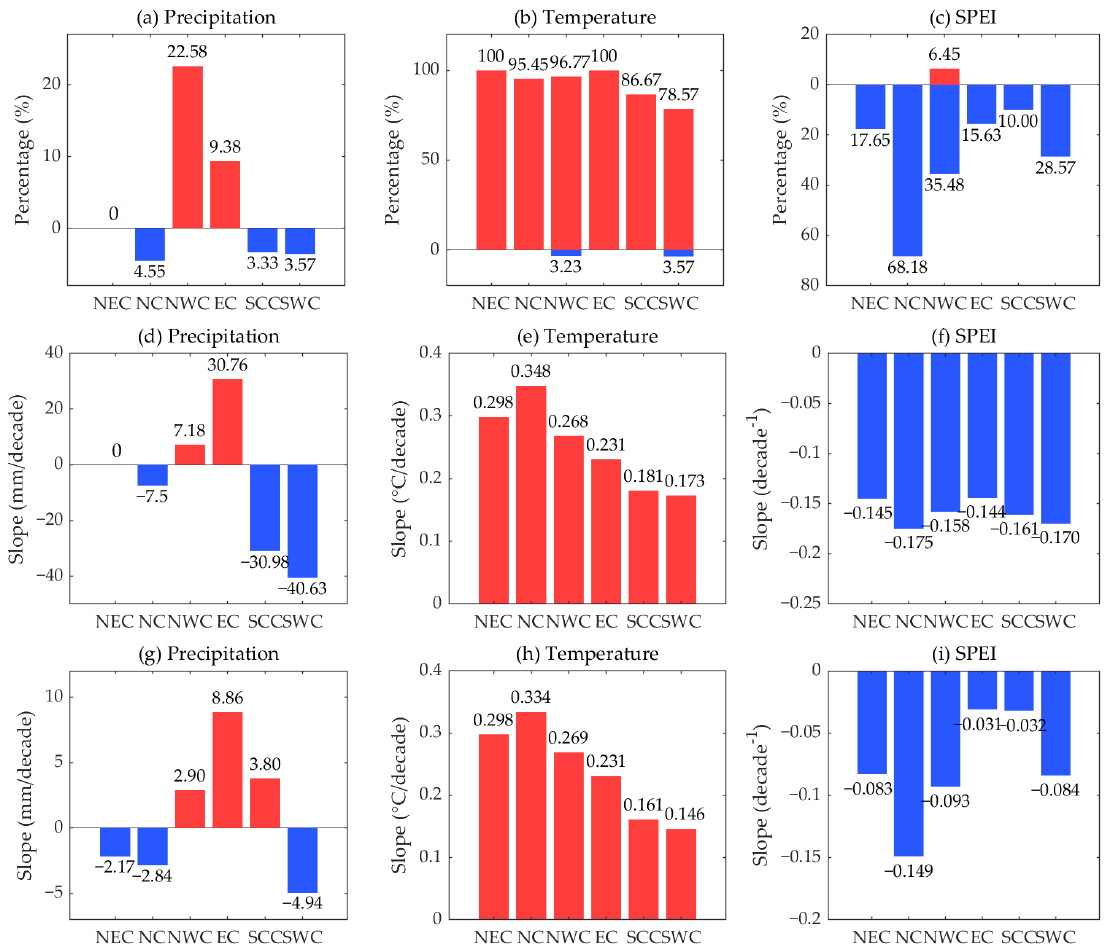
Figure 3. Percentage of stations with significant trends in the sub-regions to the total number of sta- tions during 1951–2021: ( a ) precipitation; ( b ) temperature; and ( c ) the SPEI. Red indicates an upward trend (above x-axis); blue indicates a downward trend (below x-axis). Average magnitude of changes with significant trends in the sub-regions during 1951–2021: ( d ) precipitation; ( e ) temperature; and ( f ) the SPEI. Average magnitude of trends for all sites in the sub-regions during 1951–2021: ( g ) precip- itation; ( h ) temperature; and ( i ) the SPEI. Red (blue) denotes a positive (negative) trend magnitude. Subfigures ( d – f ) consider statistically significant trends at the 95% confidence